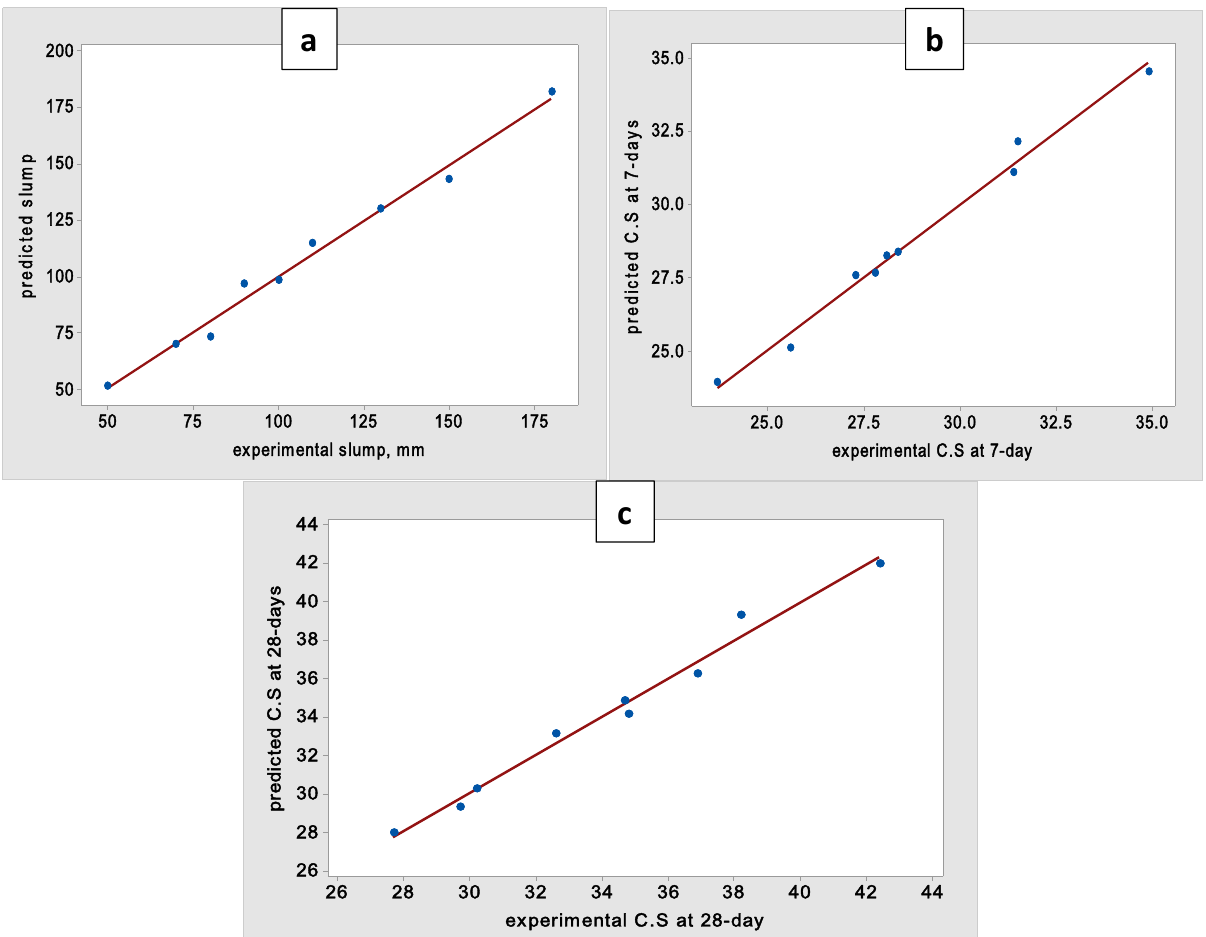
Figure 6: Comparison between experimental and predicted responses. ( a ) Slump, ( b ) CS at 7 days, ( c ) CS at 28